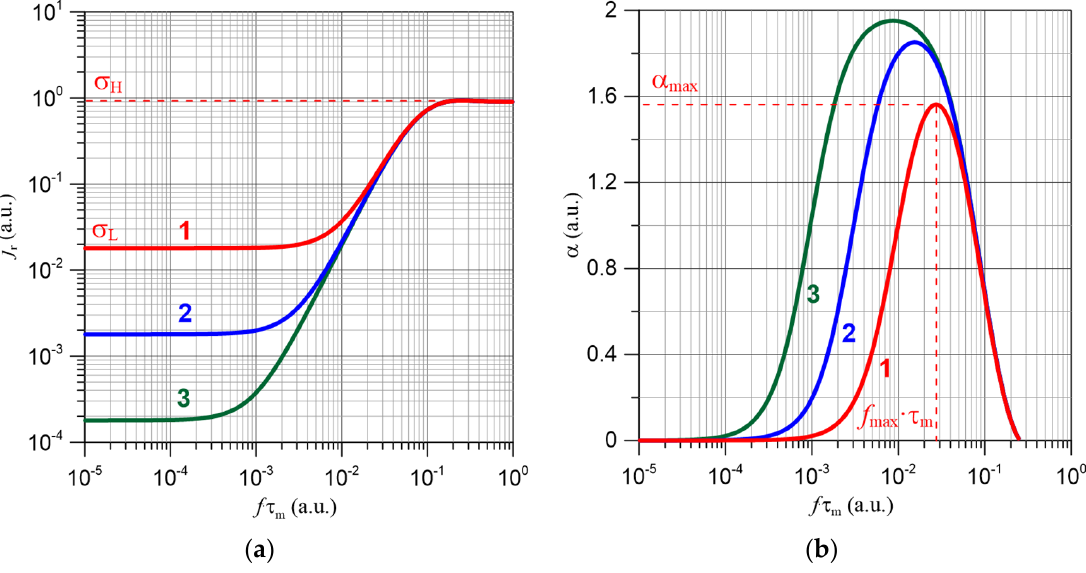
Figure 3. Relationship of the actual component of current density j r —( a ) and frequency coefficient α ( f )—( b ) as a function of the product of the frequency value f and the expected value of the relaxation time τ m . Computer simulation for: 1— p = 0.01; 2— p = 0.001; 3— p = 0.0001.